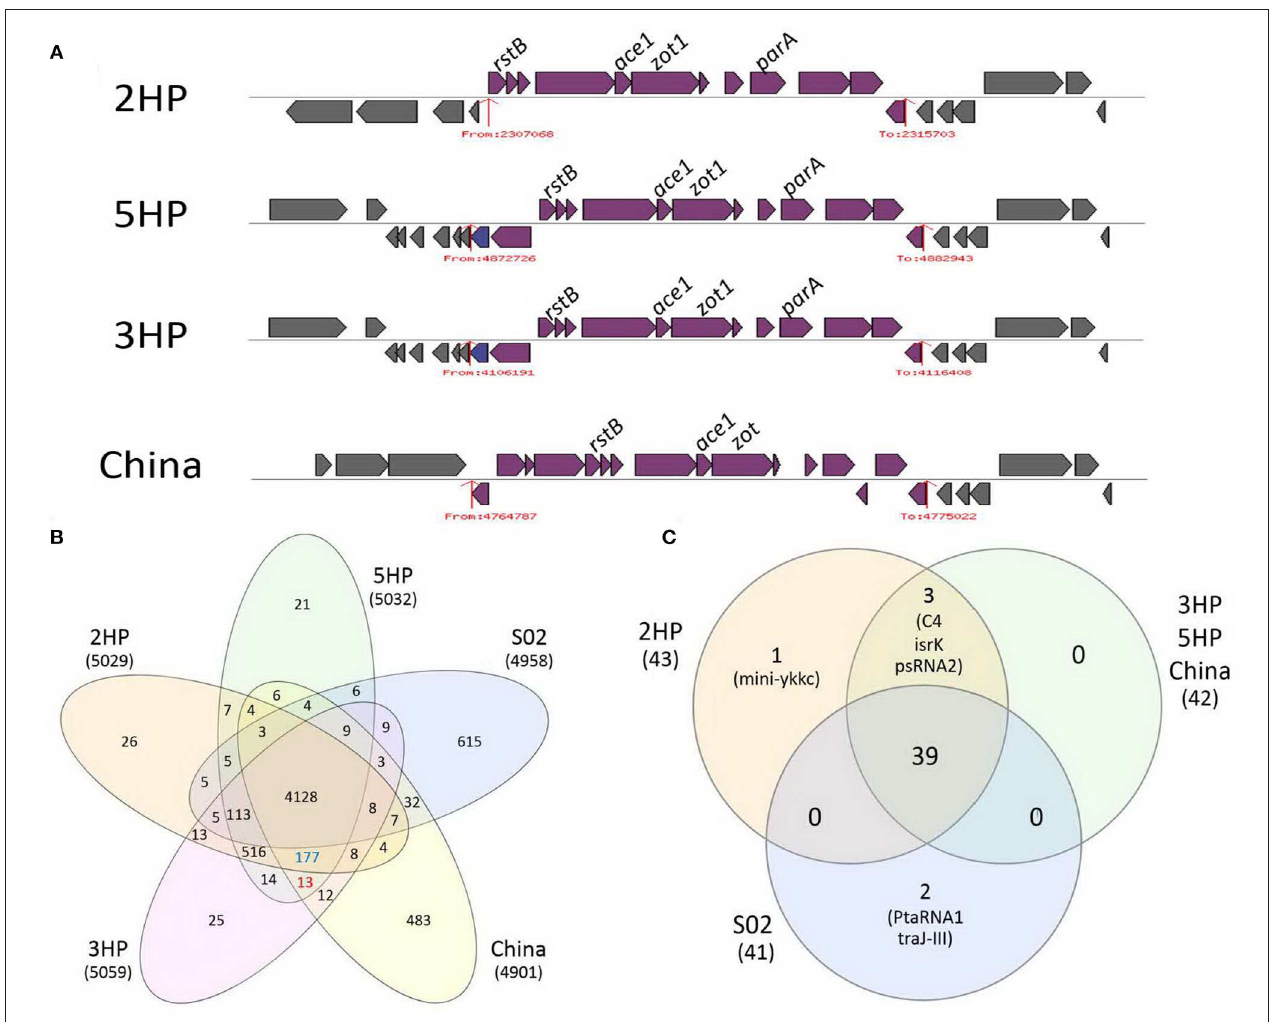
FIGURE 2 | Comparative analyses of (A) prophage structures based on VRprofile prediction, (B) protein families based on PATRIC genus-specific families, PLfams, and (C) ncRNAs (C) (based on Infernal prediction) among non-AHPND V. parahaemolyticus (2HP), V. parahaemolyticus AHPND (3HP, 5HP, and China), and non-pathogenic V. parahaemolyticus (S02). (A) The gray, purple, and dark blue blocks represent genes of outer structure of prophage, prophage, and PAI, respectively. Red arrows and numbers show boundary and start/stop positions of prophage structures. Labeled regions show regions of rstB, zot , ace , and parA -like genes. (B) shows five-circle Venn diagram of distribution of protein families across different V. parahaemolyticus genomes. The orange, purple, green, yellow, and blue circles represent 2HP, 3HP, 5HP, China, and, S02, respectively, with number of total genes in each strain. The overlapped areas show shared protein families among strains, and numbers of proteins found in all strains are shown. Numbers of specific features in AHPND (3HP, 5HP, and China) and EMS (AHPND strains and 2HP) areas show in red and blue, respectively. (C) shows ncRNA prediction in V. parahaemolyticus isolates. Orange, green, and blue circles represent 2HP, AHPND strains, and S02, respectively, with the number of predicted ncRNAs of each strain. The overlapped areas represent the shared predicted ncRNAs among strains, and numbers of ncRNAs found in all strains are